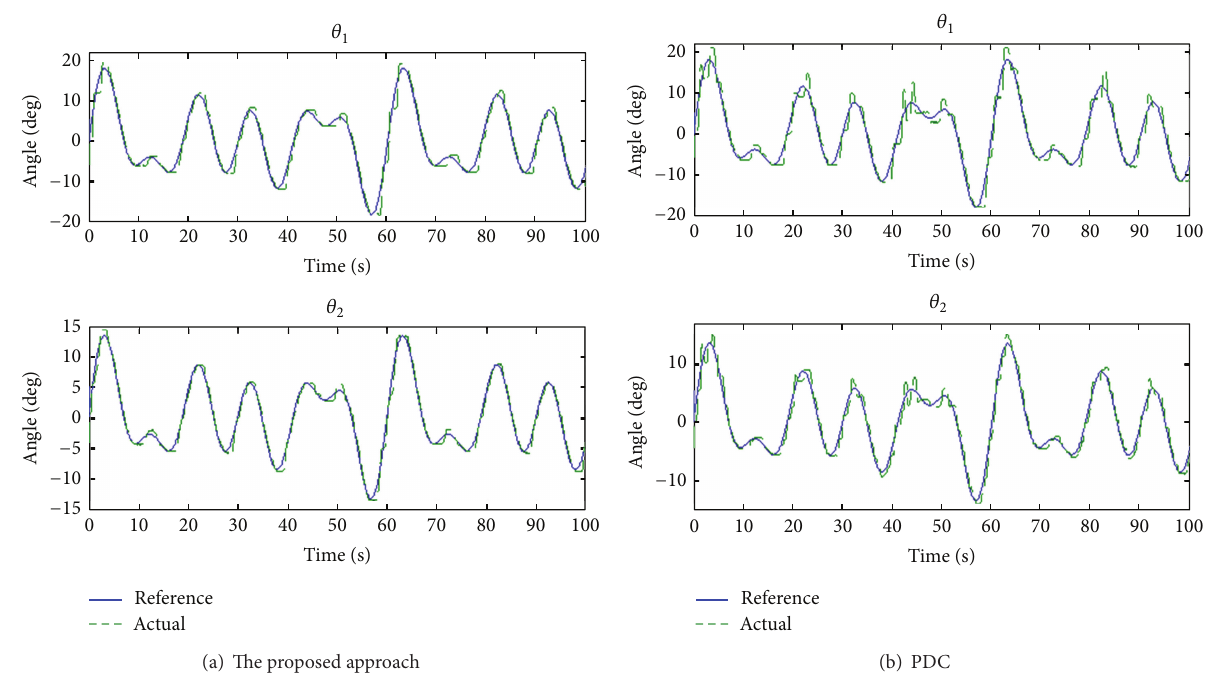
Figure 6: Irregular curve response for both knee and ankle